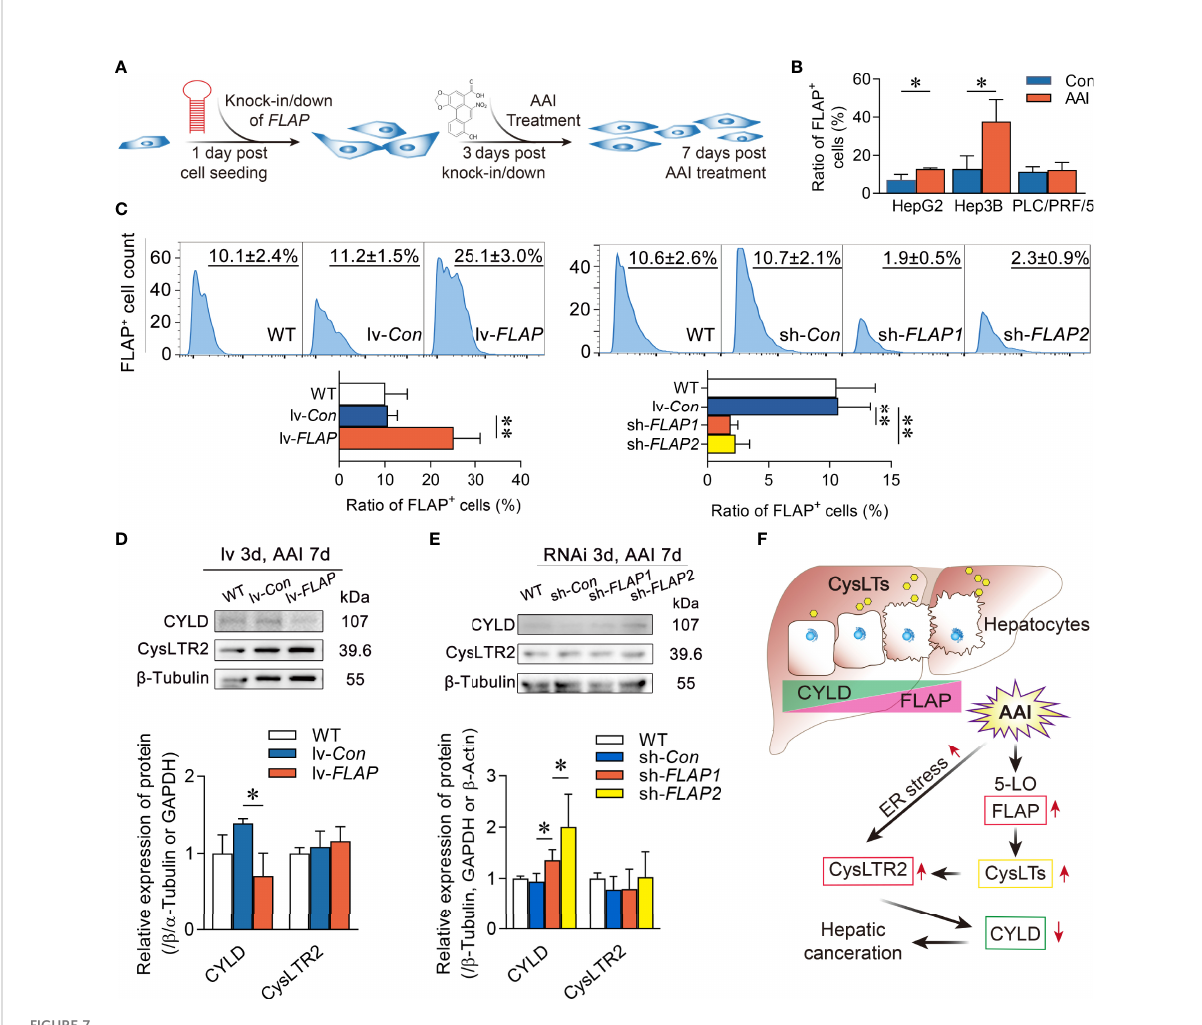
FIGURE 7 Overexpression of FLAP diminishes CYLD expression in AAI-treated HepG2 lv- FLAP cells. (A) Scheme of the experimental procedure. (B) FLAP- positive (FLAP + ) cell ratio in human HCC cell lines HepG2, Hep3B, and PLC/PRF/5 in response to AAI by fl ow cytometry assay, respectively. WT HCC cells without AAI treatment were used as control. (C) FLAP-positive (FLAP + ) cell ratio in WT, HepG2 lv- FLAP , and HepG2 sh- FLAP cells by fl ow cytometry assay. (D, E) Immunoblotting analyses of CYLD and CysLTR2 in WT, HepG2 lv- FLAP , or HepG2 sh- FLAP cells. b -Tubulin was used as loading control. (F) Schematic representation of FLAP overexpression results in CYLD attenuation in the HCC canceration process. Error bars, mean value ± SD; Student unpaired t- test was used to compare groups, and p- value less than 0.05 was considered as statistically signi fi cant. * p < 0.05 vs. control, ** p < 0.01 vs. control. For each analysis, n =